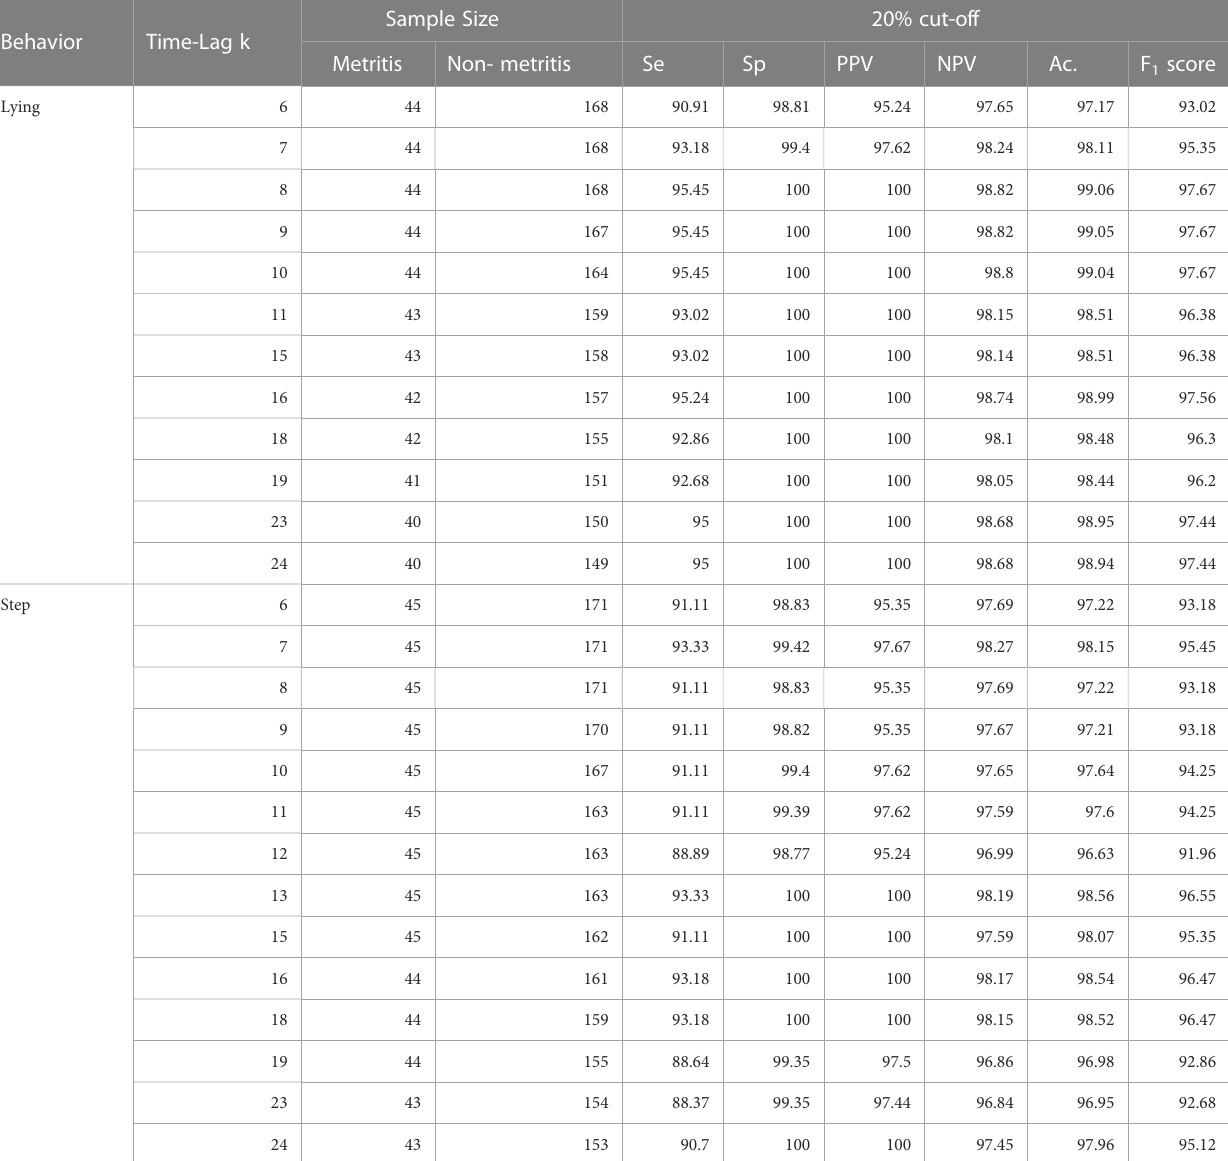
TABLE 4 Results from model ’ s performance (%) where random forest (RF) classi fi er was used on sensor data registered by a leg-attached 3-axis accelerometer (TrackaCow, ENGS, Hampshire, UK) from all day aggregated using time windows of 3 hours and the 20% cut-off as decision threshold after ranking the classi fi cation probabilities from high to